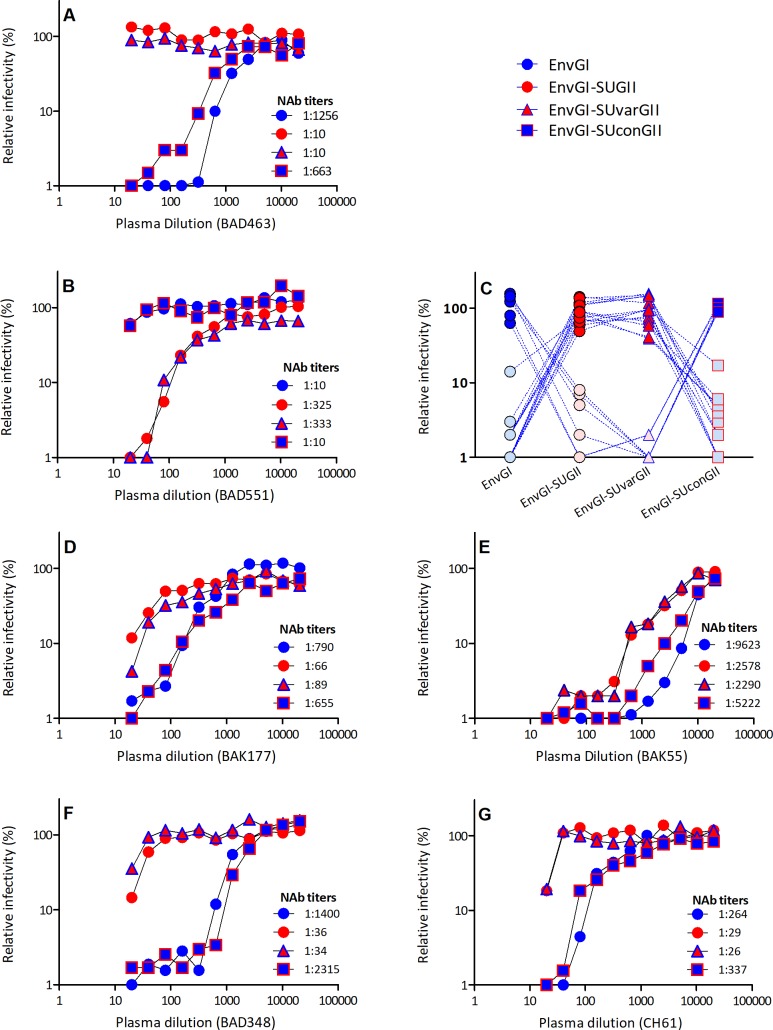
Neutralizing antibodies target the SUvar region.Neutralization assays were performed with plasma samples from gorilla SFV-infected individuals against the four FFV carrying wild-type EnvGI, chimeric EnvGI-SUGII, EnvGI-SUvarGII, and EnvGI-SUconGII. Cells were transduced with untreated FFV to provide the reference value. Relative infectivity was calculated for wells treated with plasma samples and is expressed as the percentage of the reference value. Panels A, B, and D through G present full titration curves for plasma from single neutralizers (A-B), coinfected dual neutralizers (D-E), and dual neutralizers without molecular evidence of coinfection (F-G). Panel C shows the relative infectivity after incubation with plasma samples from single neutralizers diluted 1:80. Fourteen plasma samples were specific for GI-D468 and are presented with dark blue/light pink symbols; six plasma samples were specific for GII-K74 and are presented with light blue/red symbols.